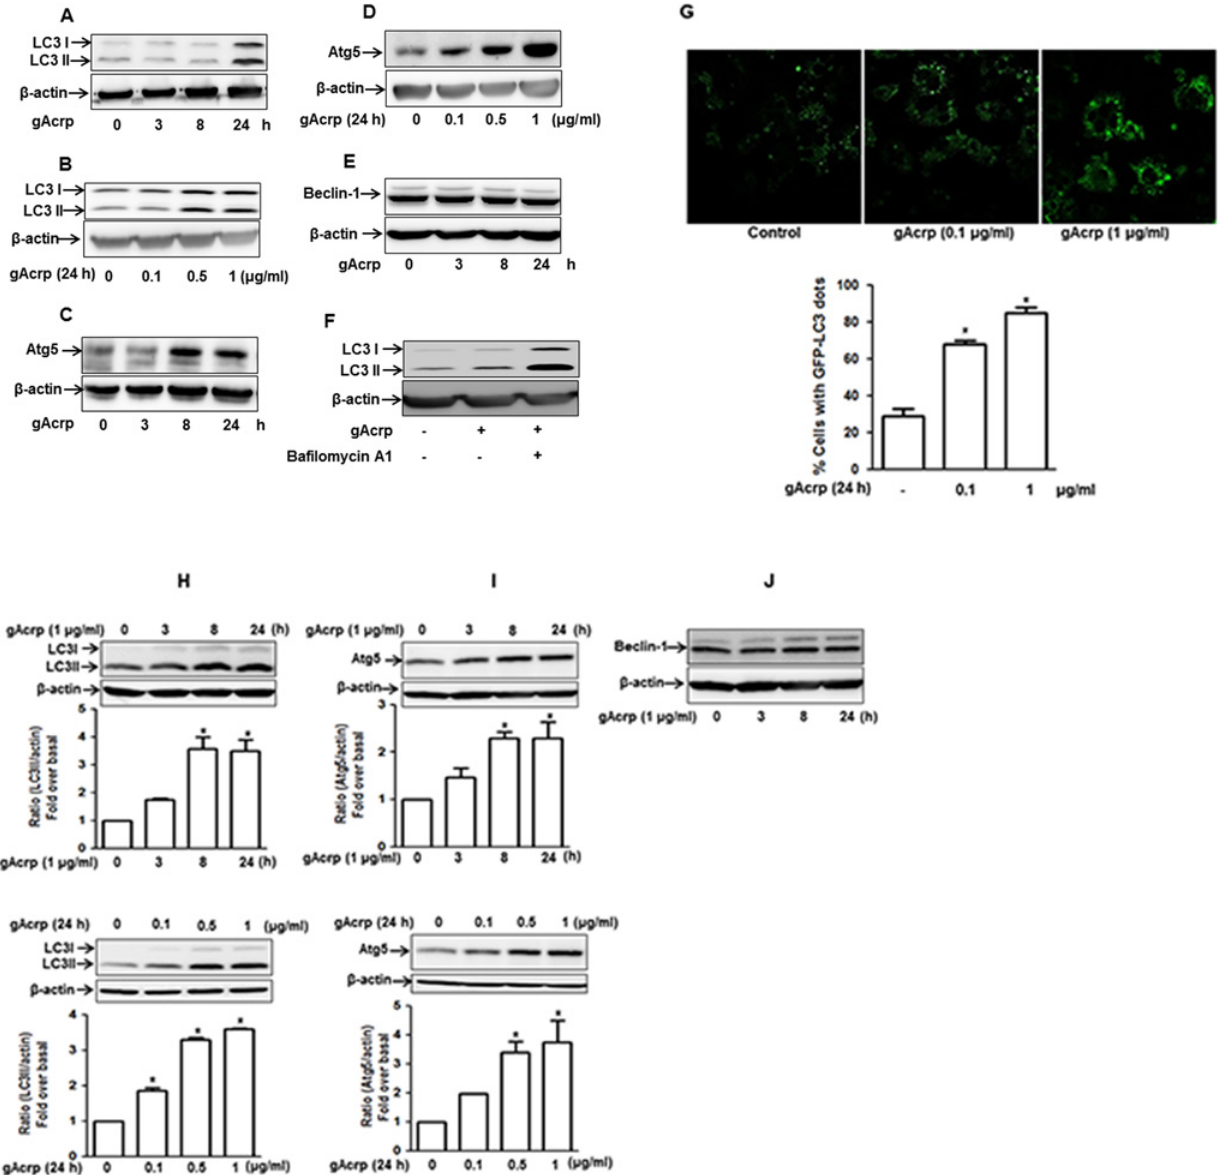
Fig 1. Effect of gAcrp on autophagy induction in RAW 264.7 macrophages and primary peritoneal macrophages. (A and B) RAW 264.7 macrophages were treated with gAcrp (1 μ g/ml) for different time duration (A) or different concentrations for 24 h (B). LC3II expression level was determined by Western blot analysis as described in materials and methods. (C and D) Cells were treated with gAcrp (1 μ g/ml) for the indicated time periods (C) or different concentrations for 24 h (D). Atg5 expression level was examined by Western blot analysis as described previously. (E) Cells were treated with gAcrp (1 μ g/ml) for the indicated time periods. Beclin-1 expression level was determined by Western blot analysis. Representative image from three independent experiments has been shown along with β -actin as internal loading control. (F) Cells were pretreated with Bafilomycin A1 (10 nM) for 2 h, followed by treatment with gAcrp (1 μ g/ml) for additional 24 h. LC3II protein level was examined by Western blot analysis as described previously. Images are representative of three independent experiments that showed similar results. (G) Cells were transiently transfected with eGFP-LC3 plasmid. After 48 h, cells were treated with indicated concentration of gAcrp for 24 h. GFP-LC3 dots formation was viewed with A1 Confocal Laser Microscope System as described in material and methods. Representative image from three independent experiments has been shown along with quantitation of LC3 dots (lower panel). Values are expressed as percentage of cells with GFP-LC3 dots obtained from at least 100 cells. (H, I and J) Primary peritoneal macrophages were isolated from mice as indicated in materials and methods. Treatment was done identical to those outlined in Fig 1A and B. Expression levels of LC3II (H), Atg5 (I) and Beclin-1 (J) were measured by Western blot analysis. Representative images are shown along with β -actin as internal loading control. Quantitative analysis of LC3II and Atg5 expression was performed by densitometric analysis and is shown in bar graph (lower panel). Values are presented as mean ± SEM. * P < 0.05 compared to control.